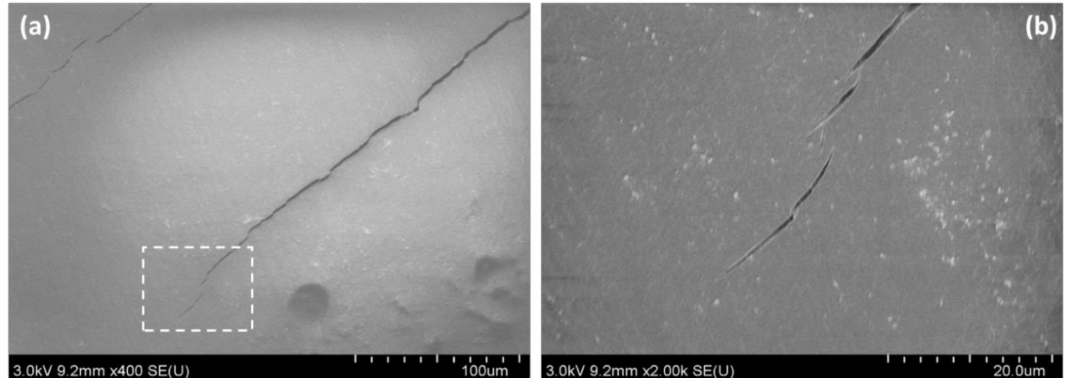
Figure 12. FE-SEM images of ( a ) microcracks on the 1 wt % SCNF nanocomposite surface and a ( b )